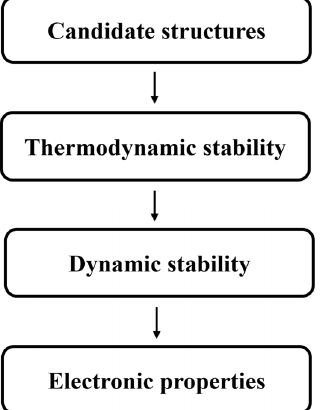
Figure 1. The schematic figure of this manuscript.